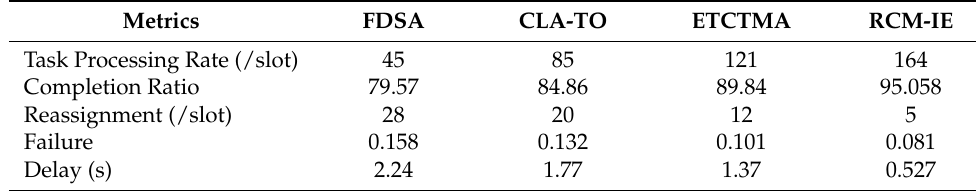
Figure 13. Delay. Table 1. Comparative analysis summary (clusters).